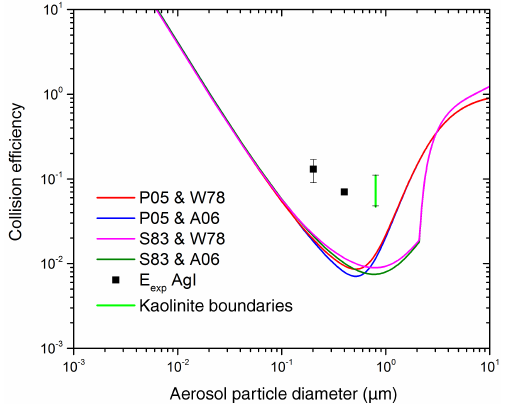
Figure 8. Total collision efficiency for a droplet of 80µm diameter as a function of aerosol particle diameter at 245K and ice satura- tion. The total collision efficiency is the sum of all individual con- tributions. The experimentally determined collision efficiency for 200 and 400nm silver iodide particles colliding with 80µm water droplets is shown by squares. The error bars represent the uncer- tainty level derived by optimizing the collision efficiency to the up- per and lower limits of experimentally determined frozen fractions shown by the symbols in Fig. 4. The green line shows the upper and lower bound for 800nm kaolinite particles. Since the assump- tion of a freezing efficiency of 1 is not valid at any temperature for kaolinite, no plateau region is available for evaluation. We can there- fore only give upper and lower boundaries of collision efficiency for these